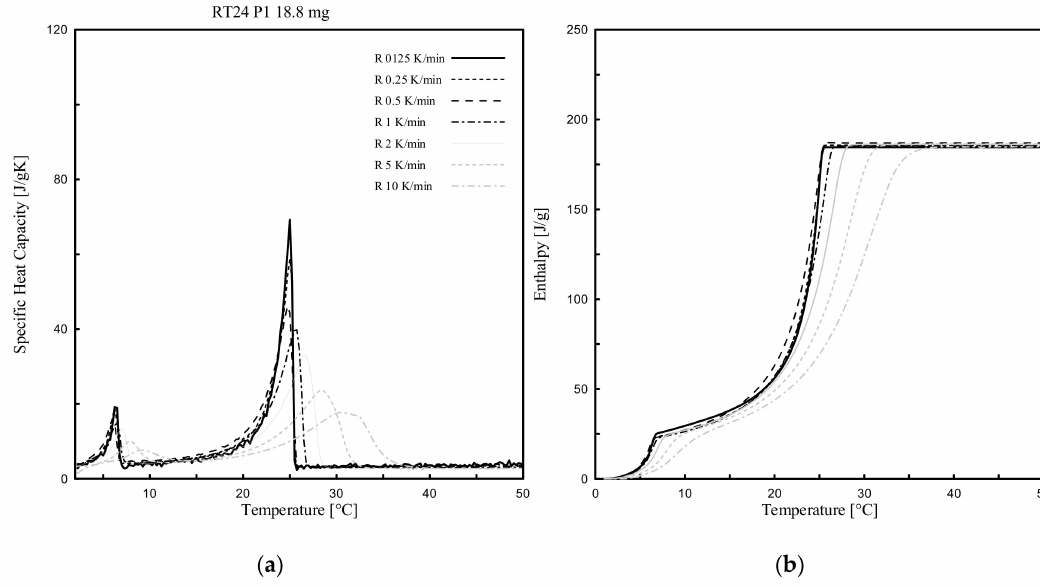
Figure 5. Dynamic DSC measurements: ( a ) c p (T) and ( b ) h(T) curves (latent only) with di ff erent heating rates for